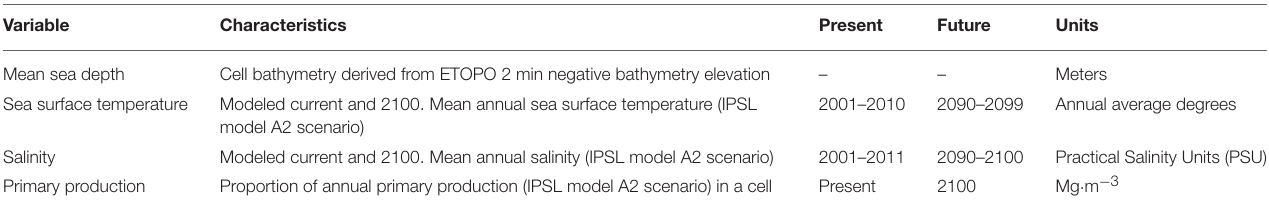
TABLE 1 | Environmental data used to generate the species distribution models (Present) and to project the data (Future) from AquaMaps database.